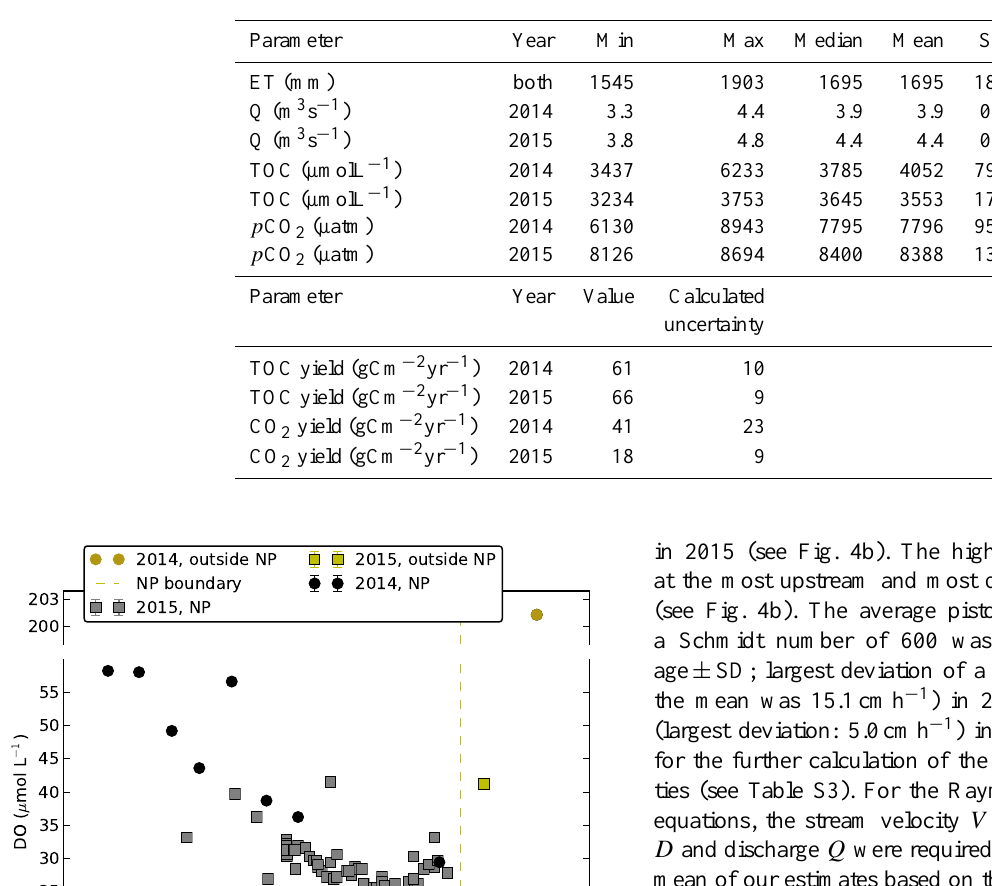
Table 2. Summary of all fluxes and their ranges. For details see text.